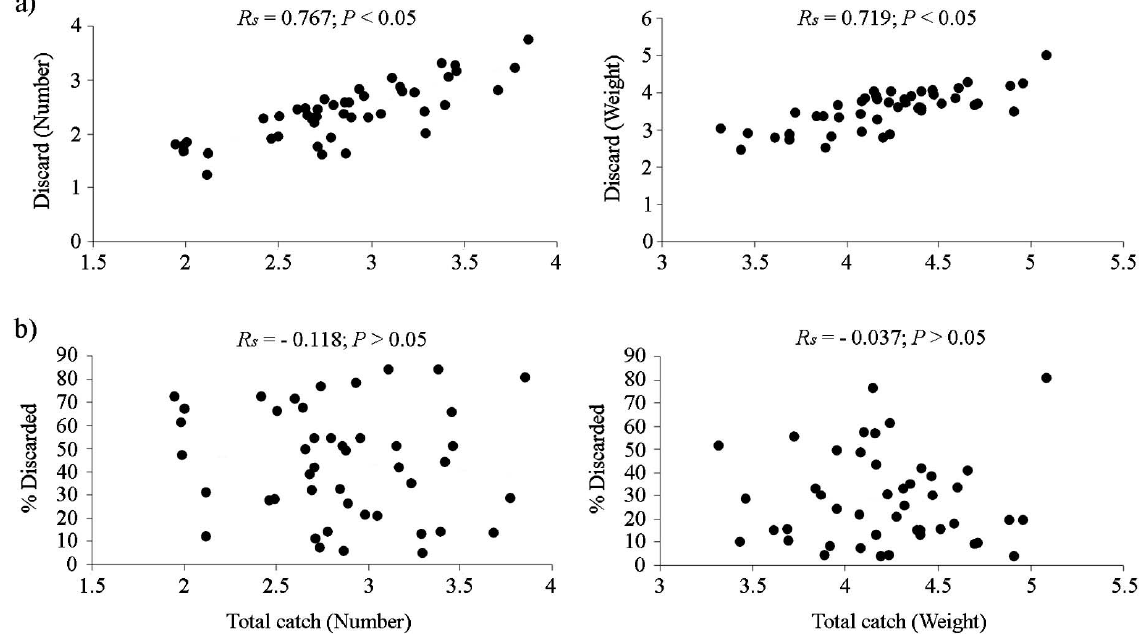
Fig . 3. – (a) Discarded catch per haul (log-transformed) and (b) discard rates vs total catch per haul (log-transformed) in both numbers and weight (weight in